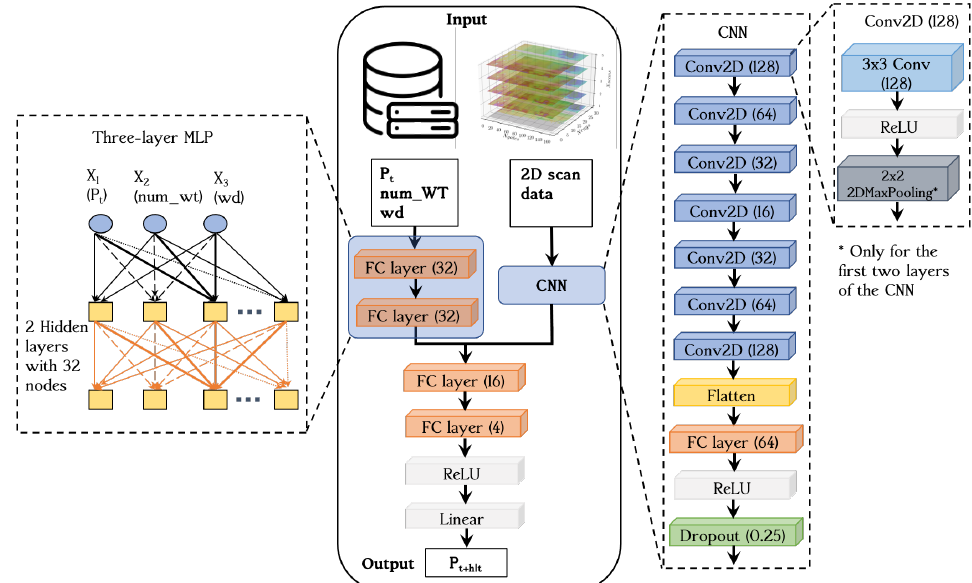
Figure 6. Architecture of the DCNN. The number in brackets after the fully-connected (FC), Conv2D and dropout layer refers to the hidden layer node number, the convolution filter number and the dropout rate, respectively.